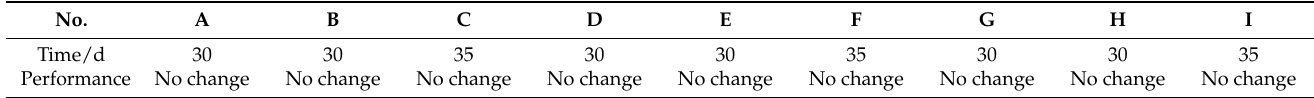
Table 9. Results for Design 1 (water resistance